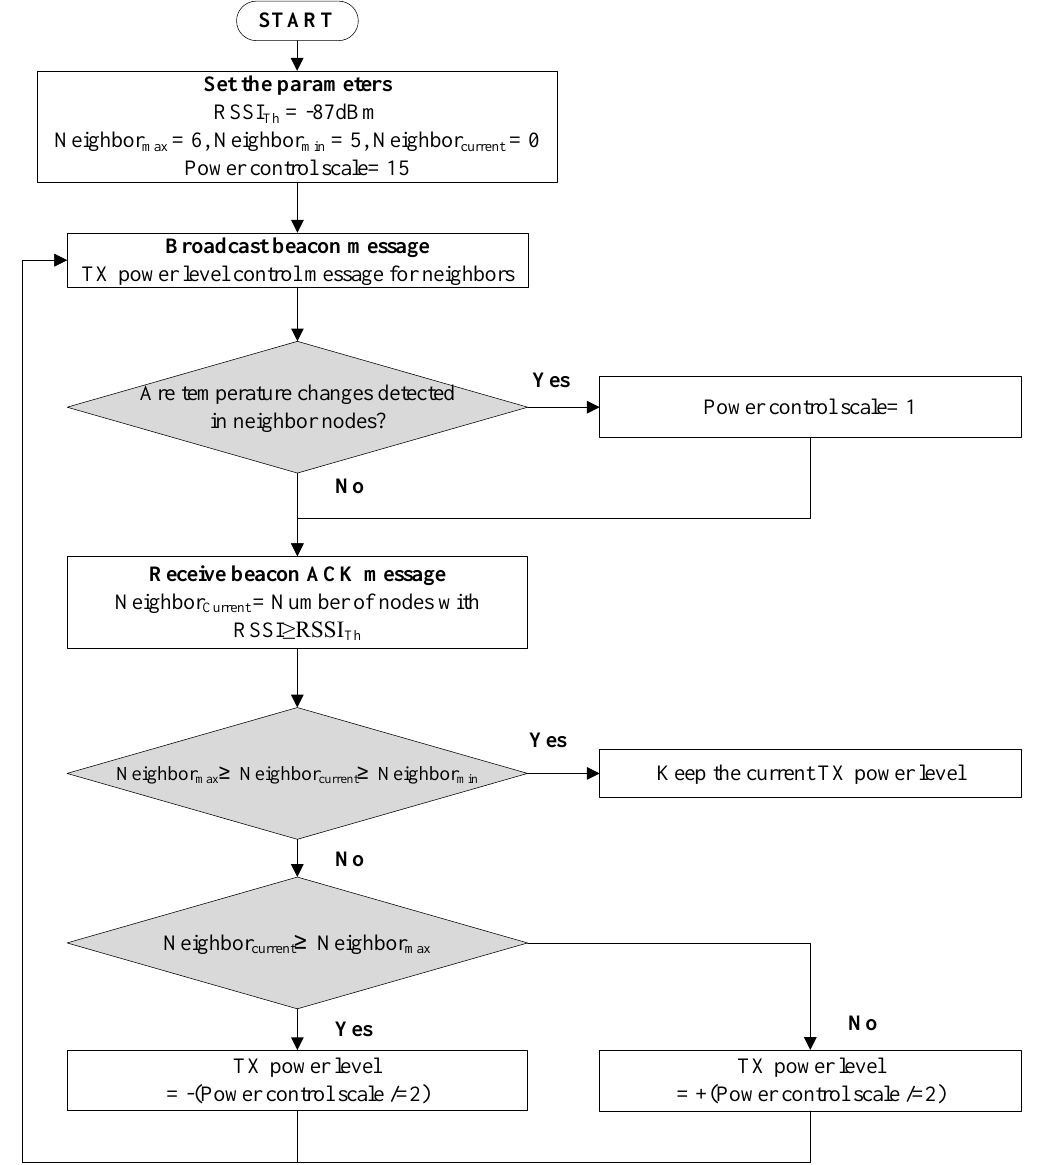
Figure 8. The flowchart of the reference